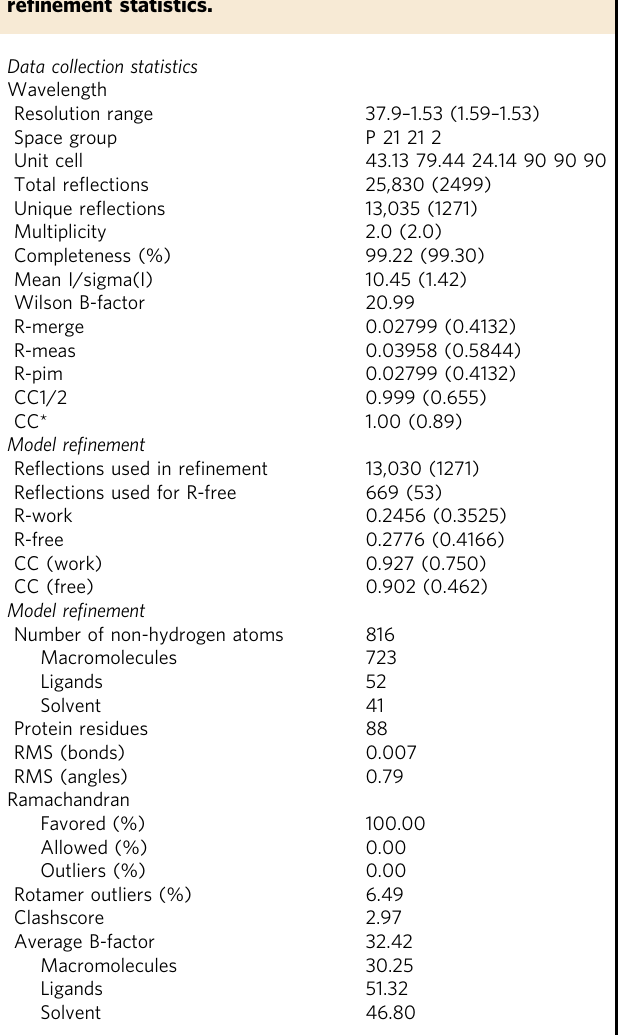
Table 3 X-ray crystallography data collection and re fi nement